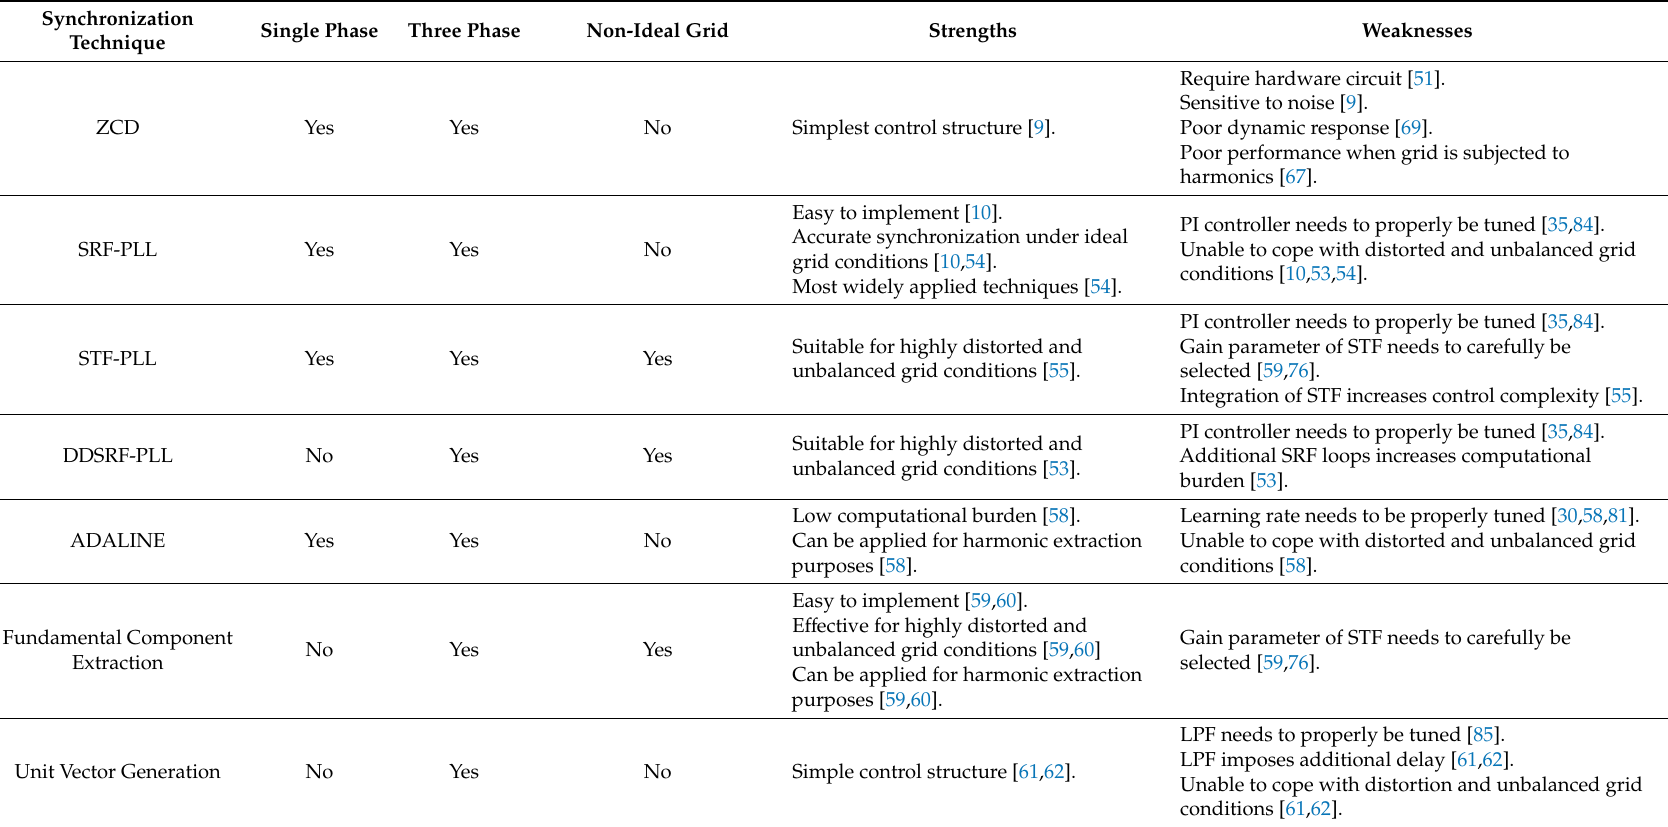
Table 1. Feature comparison of the synchronization techniques discussed in this